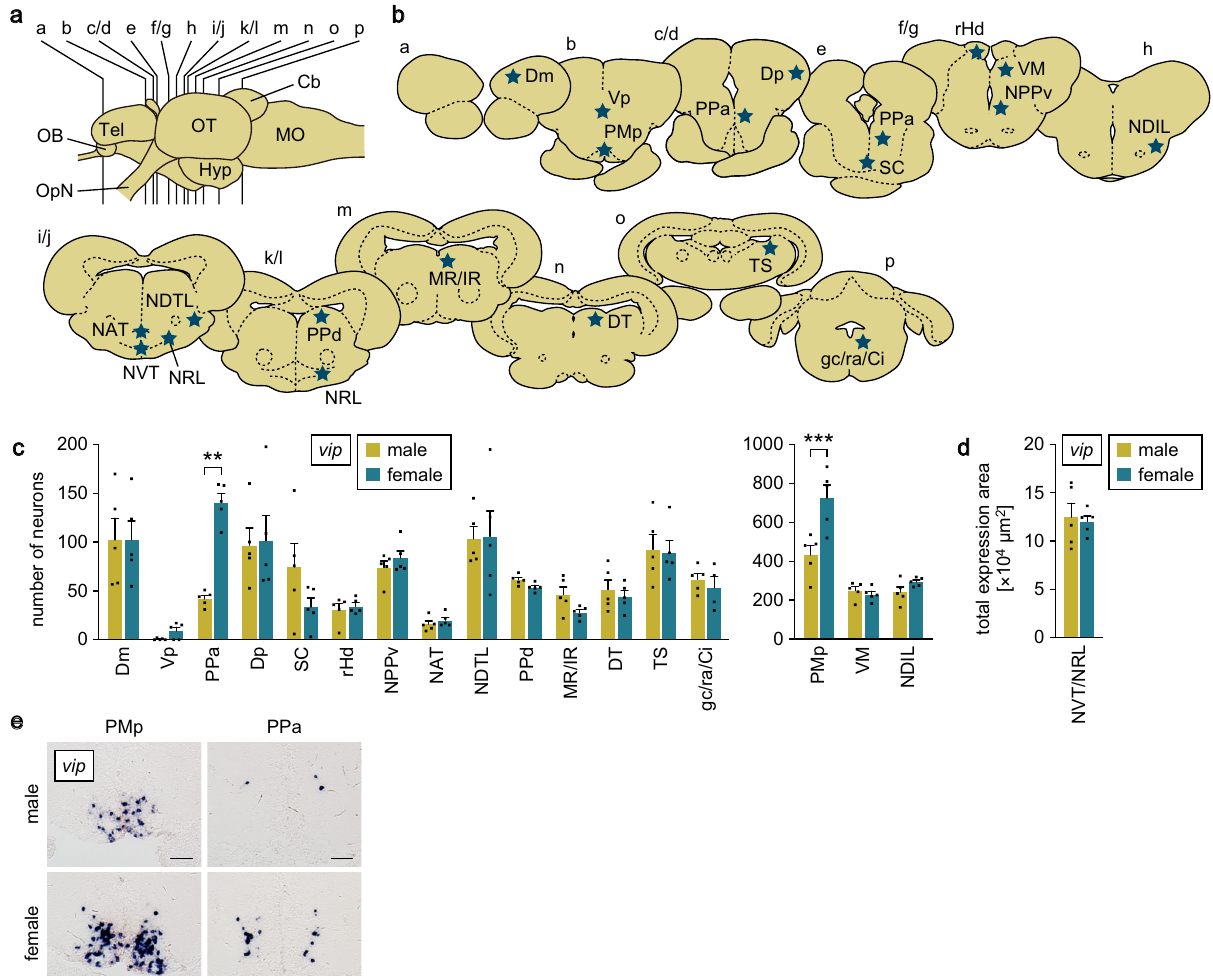
Fig. 3 The POA is the major source of the sex-biased expression of vip in the brain. a Lateral view (anterior to the left) of the medaka brain showing the approximate levels of sections in panel b . b Line drawings of coronal brain sections showing the location of nuclei containing vip -expressing neurons (stars). c Number of vip -expressing neurons in each brain nucleus of males and females ( n = 5 per sex, except gc/ra/Ci in females, where n = 4). The data are split into two graphs for clarity. d Total area of vip expression signals in the NVT/NRL nucleus, where vip -expressing neurons were tightly clustered, and their exact number could not be determined ( n = 5 per sex). e Representative micrographs showing vip expression in nuclei where signi fi cant differences between the sexes were detected. Scale bars represent 50 μ m. Quantitative data were expressed as means with error bars representing standard error of the mean. Statistical differences were assessed by unpaired t -test with Bonferroni-Dunn correction ( c , d ). ** p < 0.01; *** p < 0.001. For abbreviations of brain nuclei, see Supplementary Table